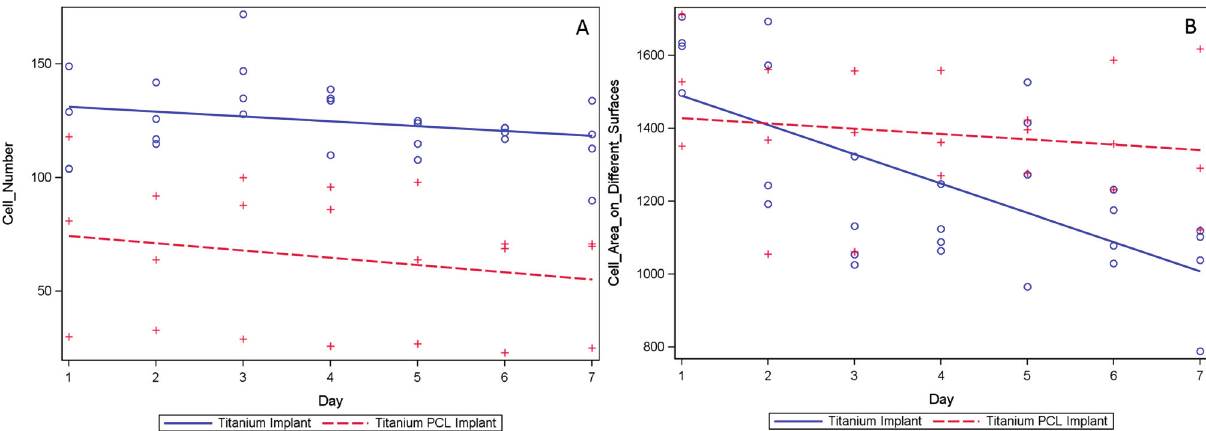
Figure 6. Evaluation of average GFP–osteoblast cell number changes ( A ) and cell spreading area (µm 2 /cell) changes ( B ) during seven days settled on titanium (the solid line represents the cell development on the titanium implant with the single time points: ○ ) and titanium PCL implants(the dotted line represents the cell development on the titanium PCL implant with the single time points: +). The statistical approach used is comparison of the two regression coefficients using an analysis of covariance with a test of the interaction between the two implant materials and time with n > 3 ( p < 0.05). The regression curves showed no changes in the number of cells over seven days, however there was a difference in the cell spreading